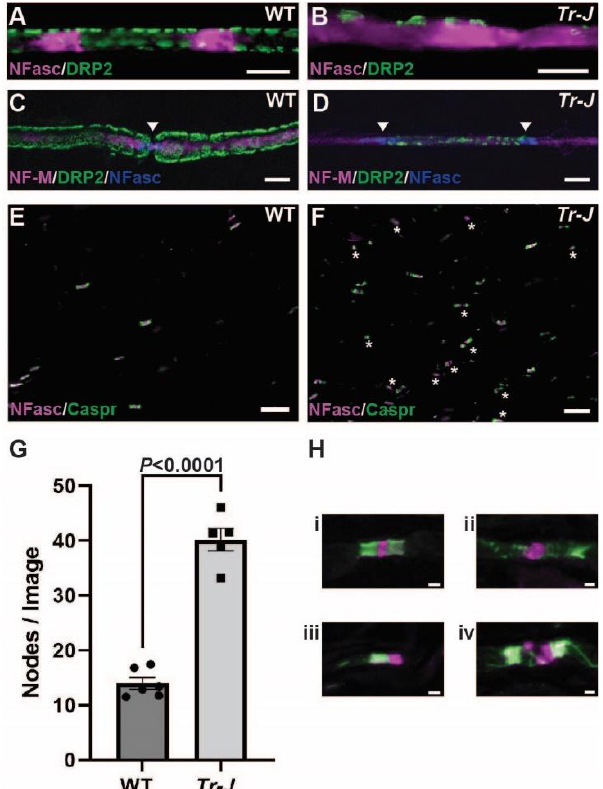
Figure 2. Myelin defects in Trembler-J mouse sciatic nerves at 8 weeks of age. ( A – D ) Representative immunostaining of teased sciatic nerve fibers from wild-type (WT) ( A , C ) and Trembler-J ( Tr-J ) mice ( B , D ). Expression and localization of Schwann cell myelin protein dystrophin-related protein 2 (DRP2, green) typically appears as a cobblestone appearance ( A , C ) but is reduced or altered in Tr-J nerves ( B , D ). Neurofascin (NFasc, violet) appears to localize to Schmidt-Lanterman incisures in WT nerve ( A ), but staining is diffuse in Tr-J nerve ( B ). Neurofilament (NF)-M (violet) localized to the axonal cytoskeleton is preserved ( C , D ). Anti-neurofascin antibody used in this immunofluorescence strongly reacts to neurofascin 186 at nodal axolemma, and weakly reacts to neurofascin 155 at paranodes and Schmidt-Lanterman incisures in Schwann cells. Arrowheads indicate nodes of Ranvier (NFasc, blue) and show an abnormally short internodal length in the Tr-J nerve ( D ). Scale bars = 10 µm ( A – D ). ( E , F ) Representative immunostaining of sciatic nerve sections from WT ( E ) and Tr-J ( F ) mice for paranodal protein Caspr in green and neurofascin in violet. In ( F ), stars indicate examples of disrupted nodes of Ranvier in Tr-J mouse sciatic nerves. Scale bars = 20 µm ( E , F ). ( G ) Quantification of nodes of Ranvier density per field of view (224 µm × 168 µm) from panels ( E ) and ( F ) comparing sciatic nerves of WT and Tr-J mice. Student’s t -test was used for comparison with n = 6 WT and n = 5 Tr-J . Detailed results of statistical analyses are provided in the Supplementary Information S1. ( H ) Representative examples of nodes found in Tr-J sciatic nerve sections: (i) a normal-appearing node of Ranvier with single neurofascin cluster (violet) and two Caspr clusters (green); (ii) a single neurofascin cluster with dispersed/disorganized paranodes with Caspr staining; (iii) a single neurofascin cluster and a single Caspr cluster (hemi node); and (iv) disorganized neurofascin cluster and elongated space between Caspr clusters. Scale bars = 2 µm (H i – iv).